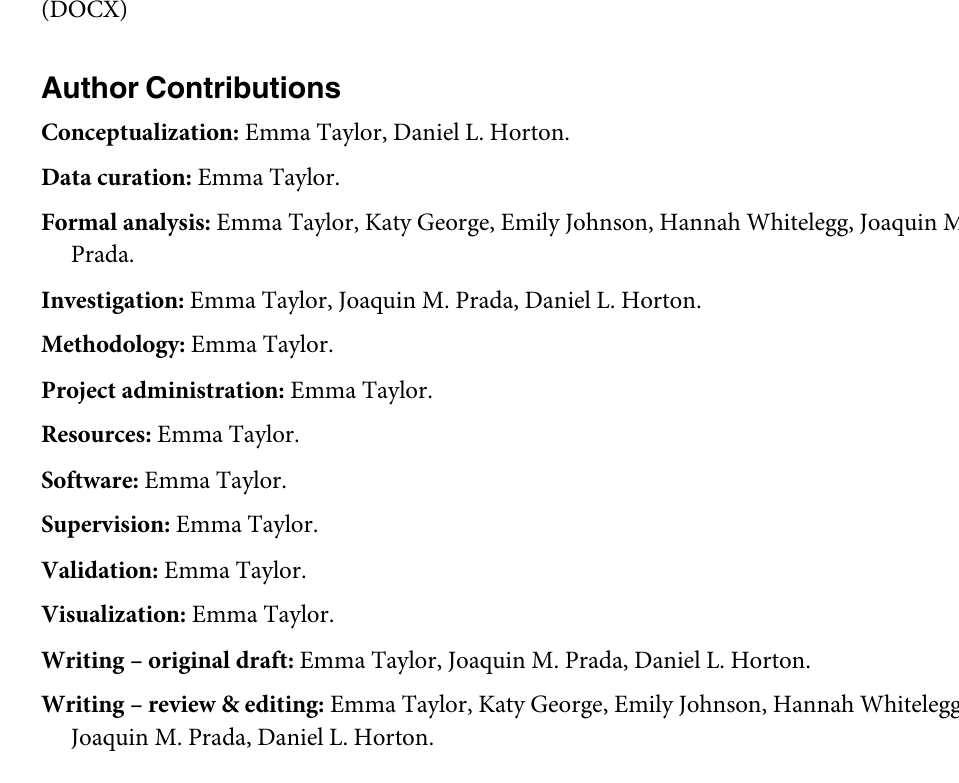
S1 Table. Summary of models used, indicating the response and explanatory values, and where data were omitted from analysis. S2 Table. Summary of the results, detailing sample size of countries include in each analy- sis, R 2 / t-value, and p-value. S1 Fig. Results from Linear Regression model with Poisson distribution showing the rela- tionship between current health expenditure (% GDP) from 2020, and per capita death rate from rabies per 100,000 population from 2015 (countries reporting more than 0.6 human deaths due to rabies). R2 = 0.081, p =